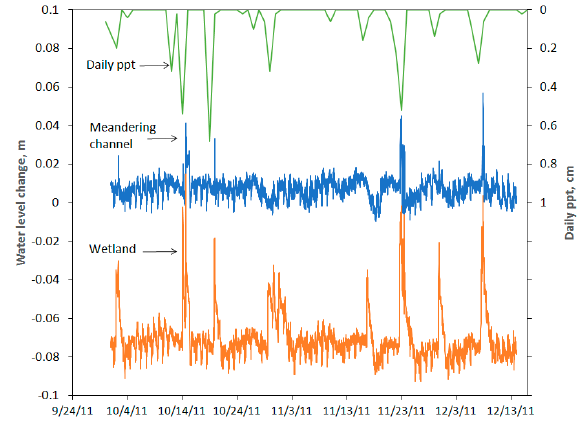
Figure 1. Comparison of stormwater overflow shown as spikes in water level in two retention basins: one with a meandering channel and one with a wetland. The baseline for the wetland was shifted down 0.08 m to show responses on the same plot.